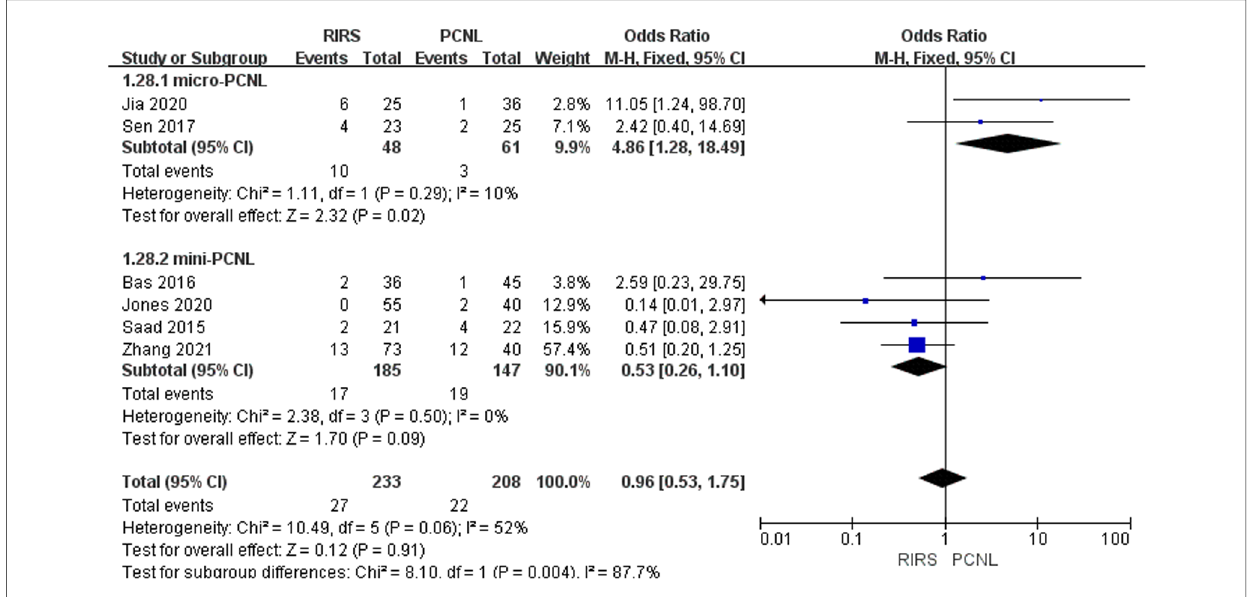
FIGURE 8 Forest plot of postoperative fever rate in the RIRS group and PCNL group.